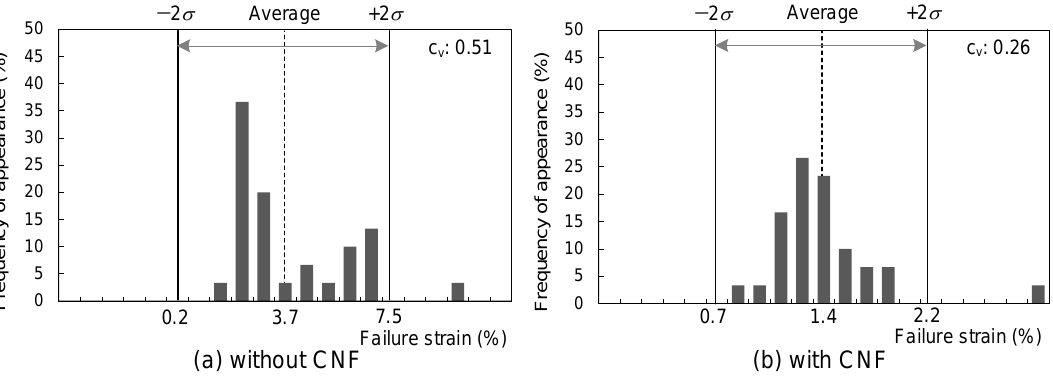
Figure 14. Frequency of appearance of failure strain.